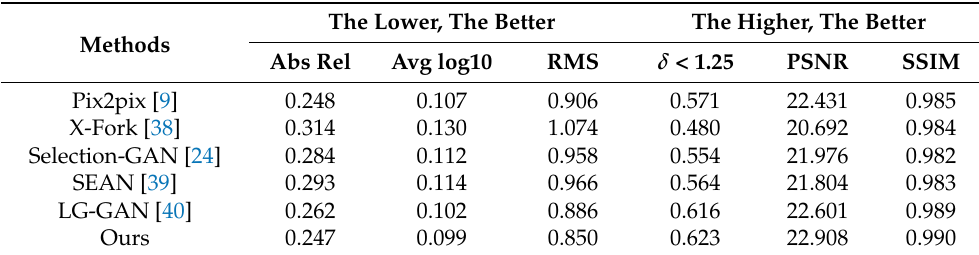
Table 1. Comparison of the algorithms in objective metrics.